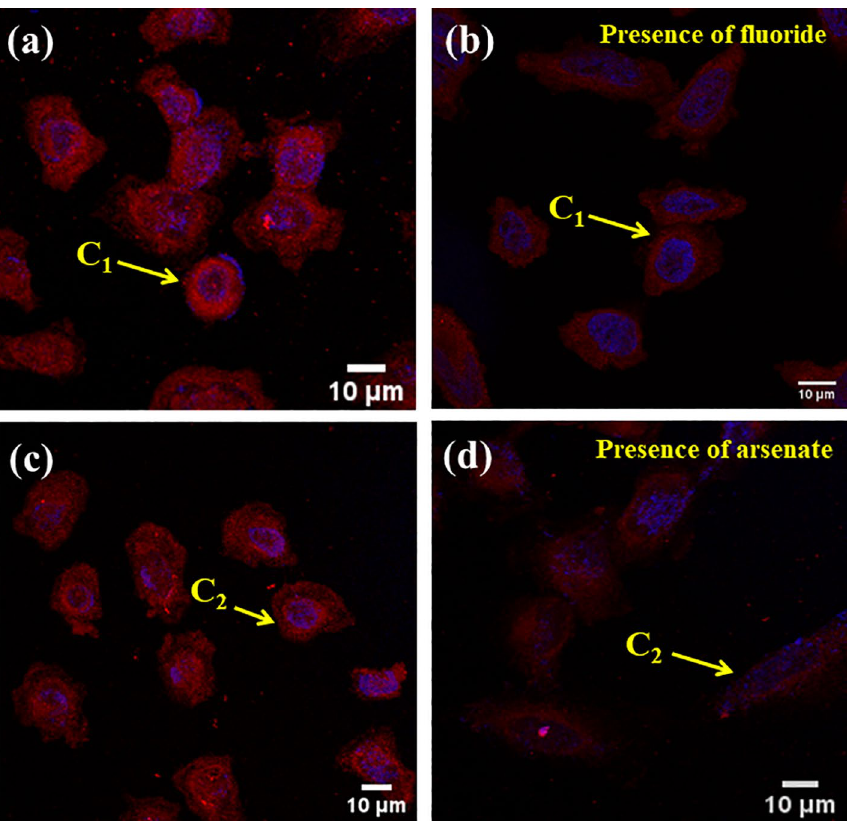
Figure 12. LSCM fluorescence imaging of SUM159 cell line with ( a ) C 1 , ( b ) C 1 + F − , ( c ) C 2 , ( d ) C 2 -AsO 4 3−